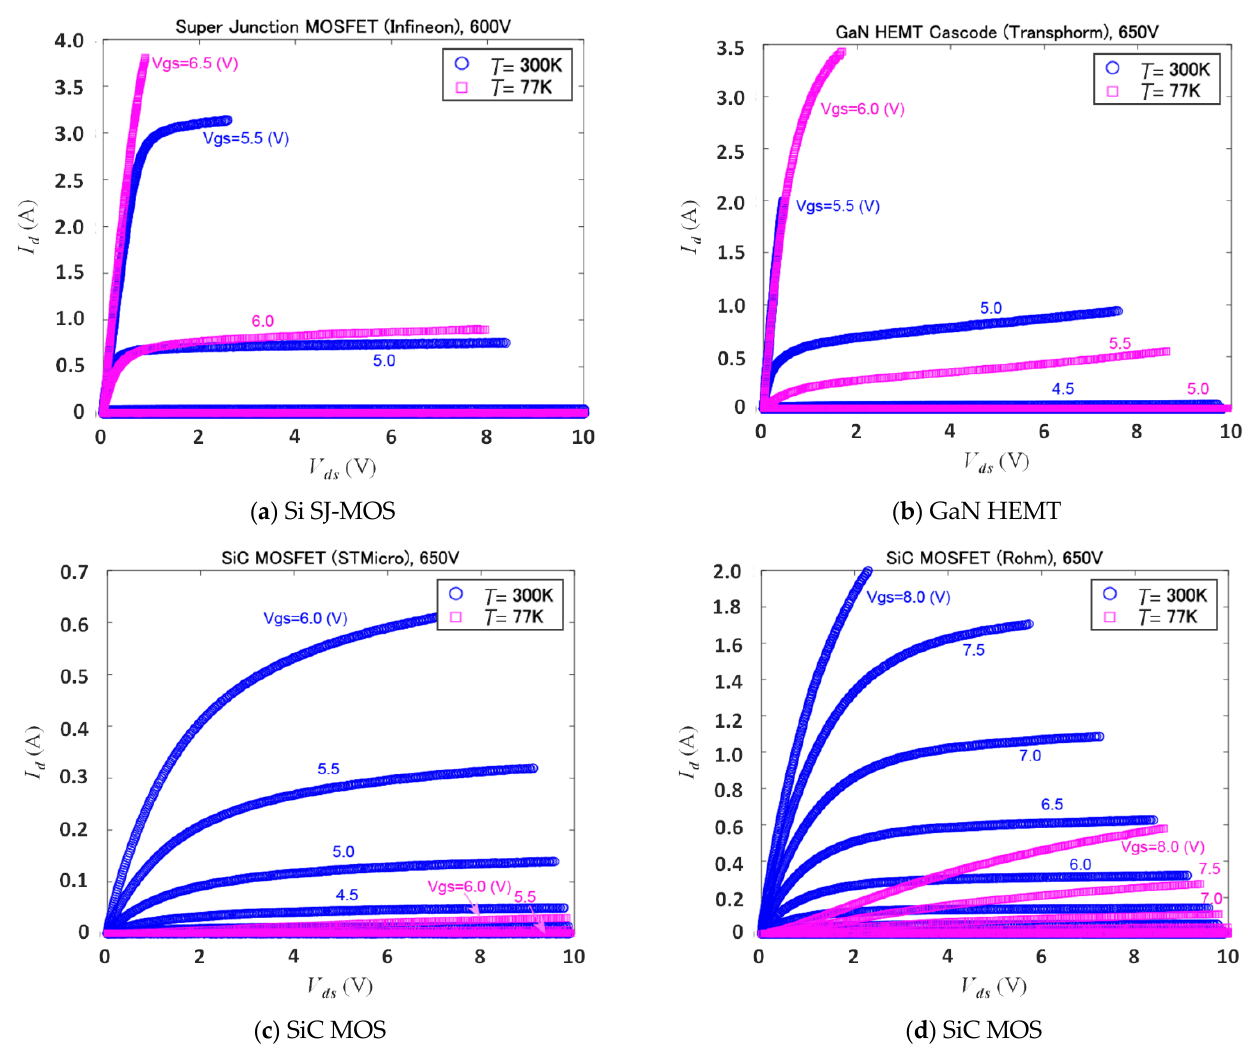
Figure 8. The experimentally measured drain characteristics at 300 K and 77 K. Table 2. Summary of the characteristics of power switches.